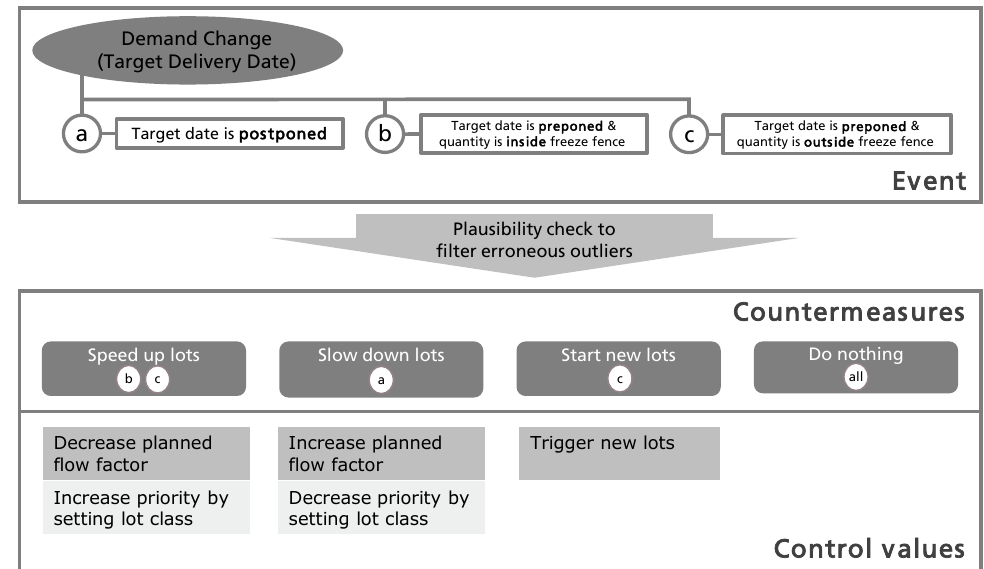
Figure 10. Countermeasures and control values for the exemplary event of a change in delivery date